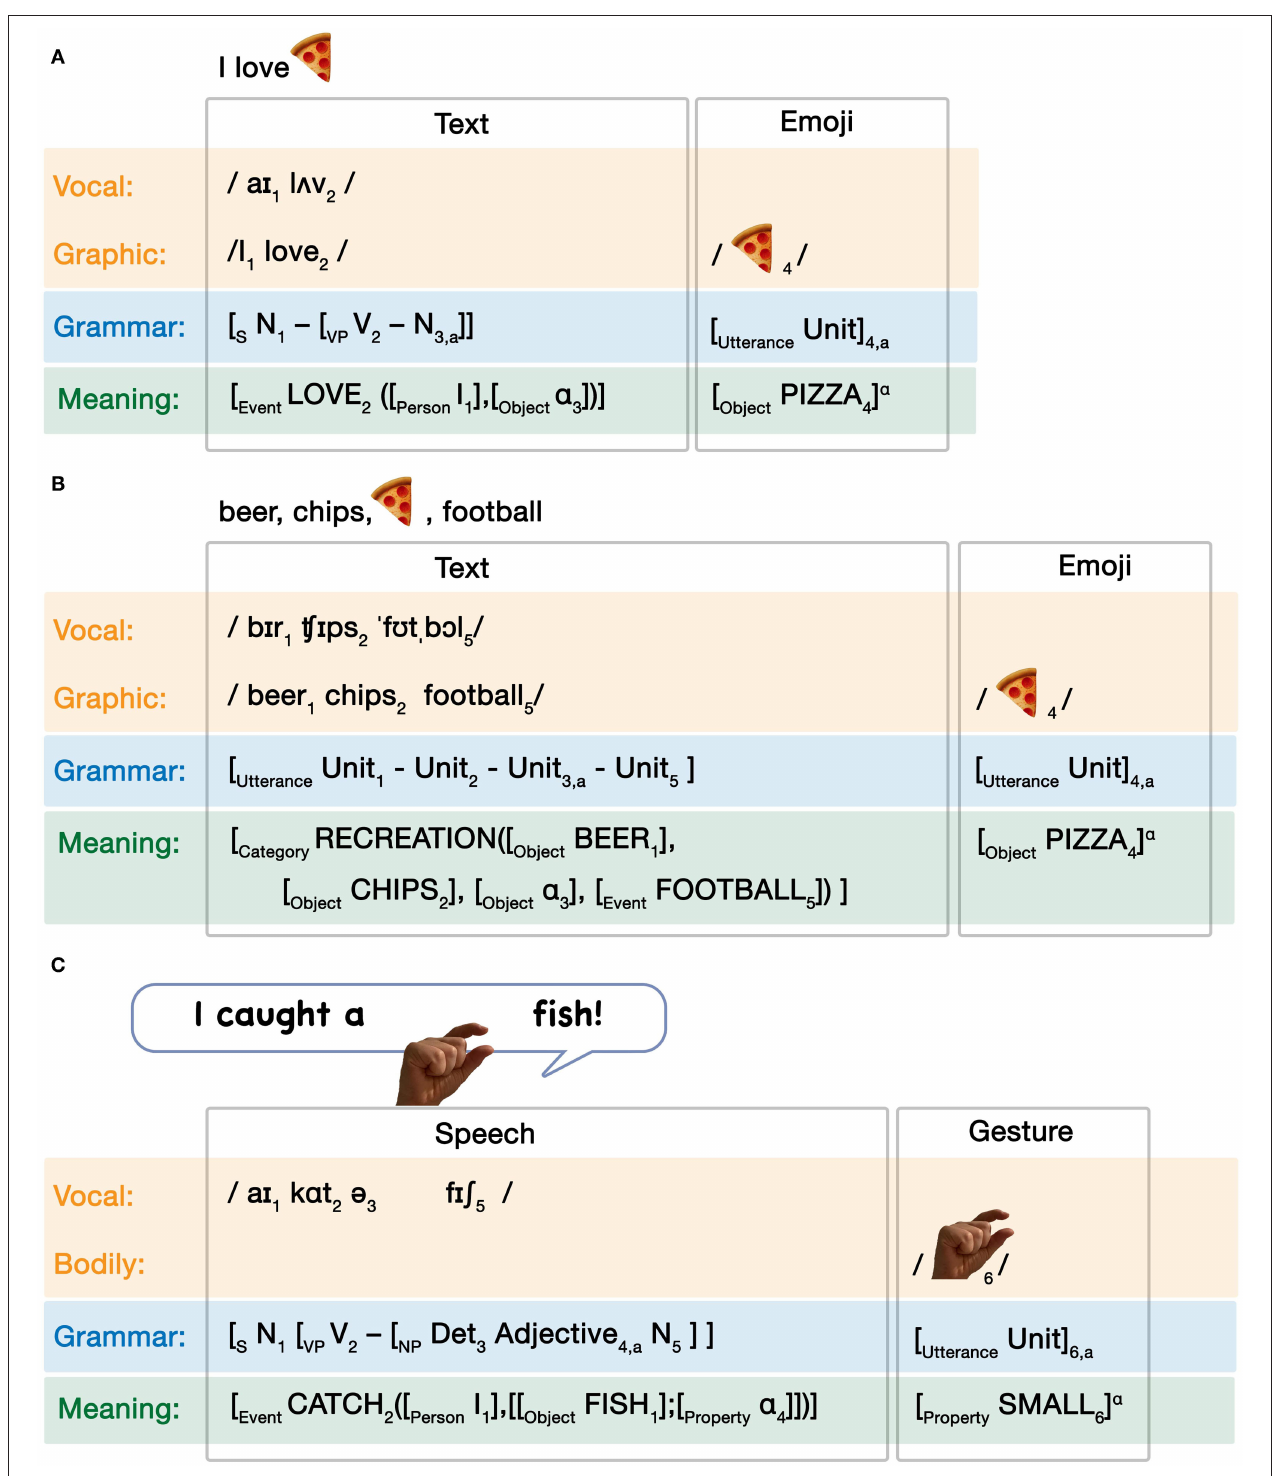
FIGURE 7 | Substitutive grammatical interactions between (A) a sentence of text and emoji, (B) a list of text and an emoji, and (C) speech and gesture.